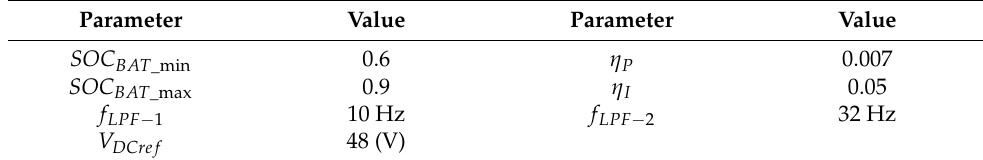
Table 11. Proposed control strategy